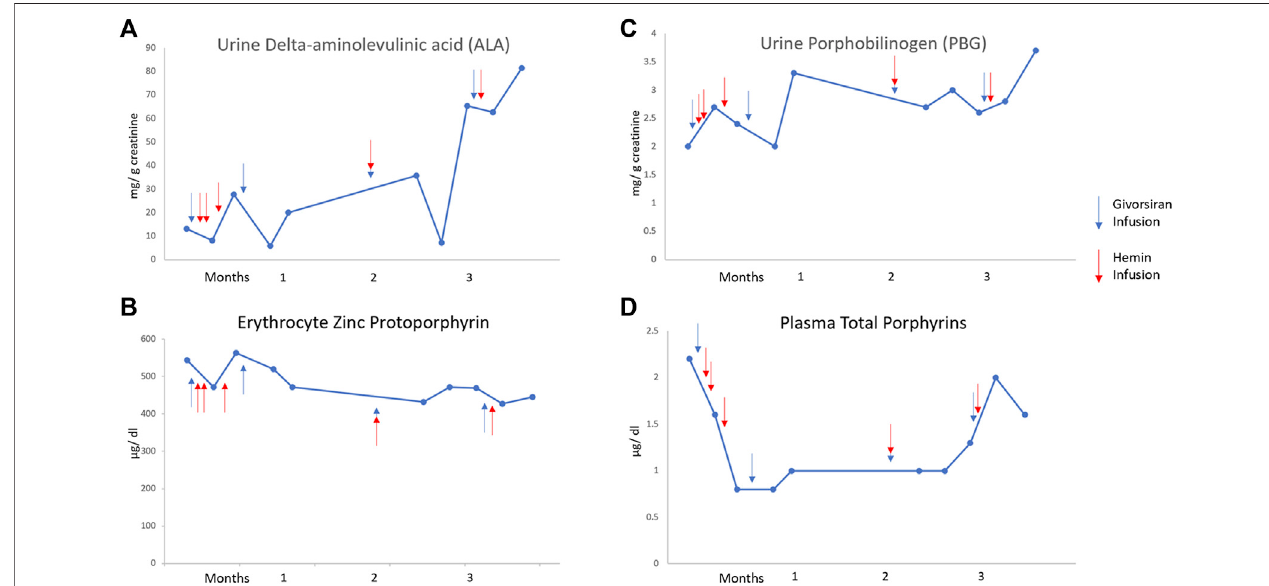
FIGURE 1 | Levels of urinary ALA (top left), urinary porphobilinogen (top right), erythrocyte zinc protoporphyrins (bottom left), and plasma protoporphyrins (bottom right) during 3 months of therapy with givosiran. Hemin and givosiran infusions are denoted by red and blue arrows, respectively. Unfortunately, our patient was hospitalized for a large portion of months 4 – 6 of givosiran therapy, thus, no subsequent levels are available.